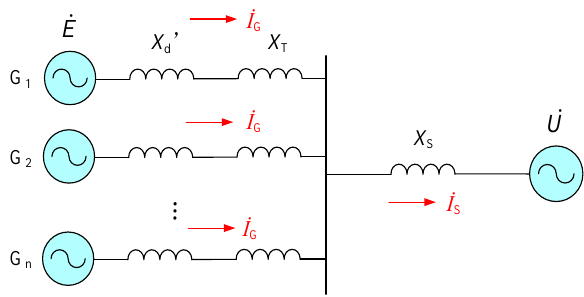
Figure 8. Schematic diagram of the multi-generators out-of-step condition.